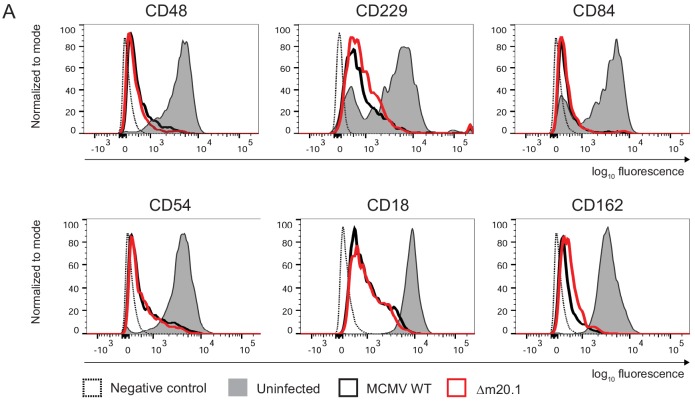
MCMV protein m20.1 is not involved in the regulation of surface molecules affected by m154.Flow cytometry analysis of surface markers of peritoneal macrophages infected with 10 PFU/cell of Δm20.1 or control WT MCMV for 72 hr or left uninfected.